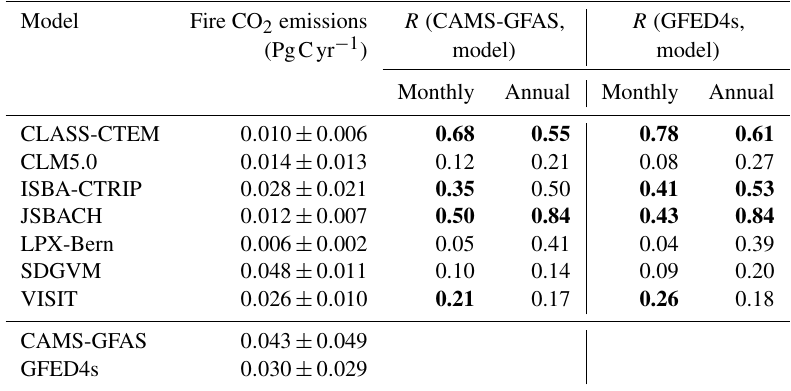
Table B3. Fire CO 2 emissions for Australia averaged over 2003–2018 and the Pearson correlation coefficients between the TRENDY models and the respective observation data. Bold numbers indicate a significant statistical relationship ( p value < 0 . 05).